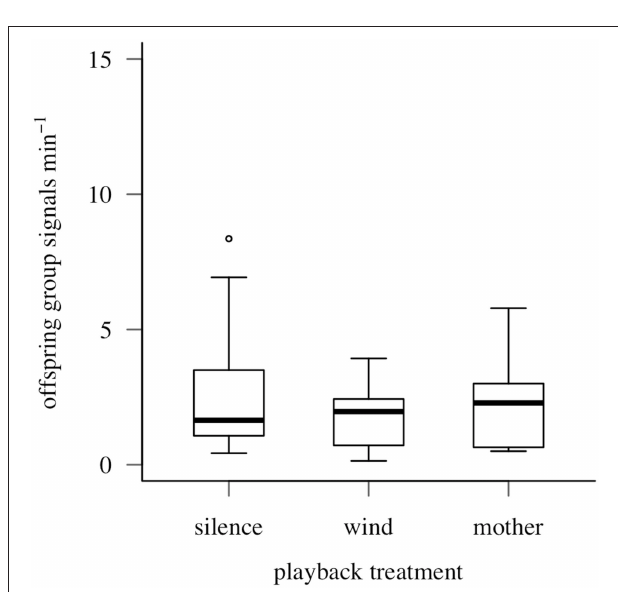
FIGURE 6 | Signaling responses of oak treehopper offspring aggregations to playback of silence, wind vibrations, or maternal post search signals after simulated predator attacks (Experiment 3). Box plots show distributions of offspring group signaling rate (minimum, first quartile, median, third quartile, maximum; open circles represent outliers). N = 10